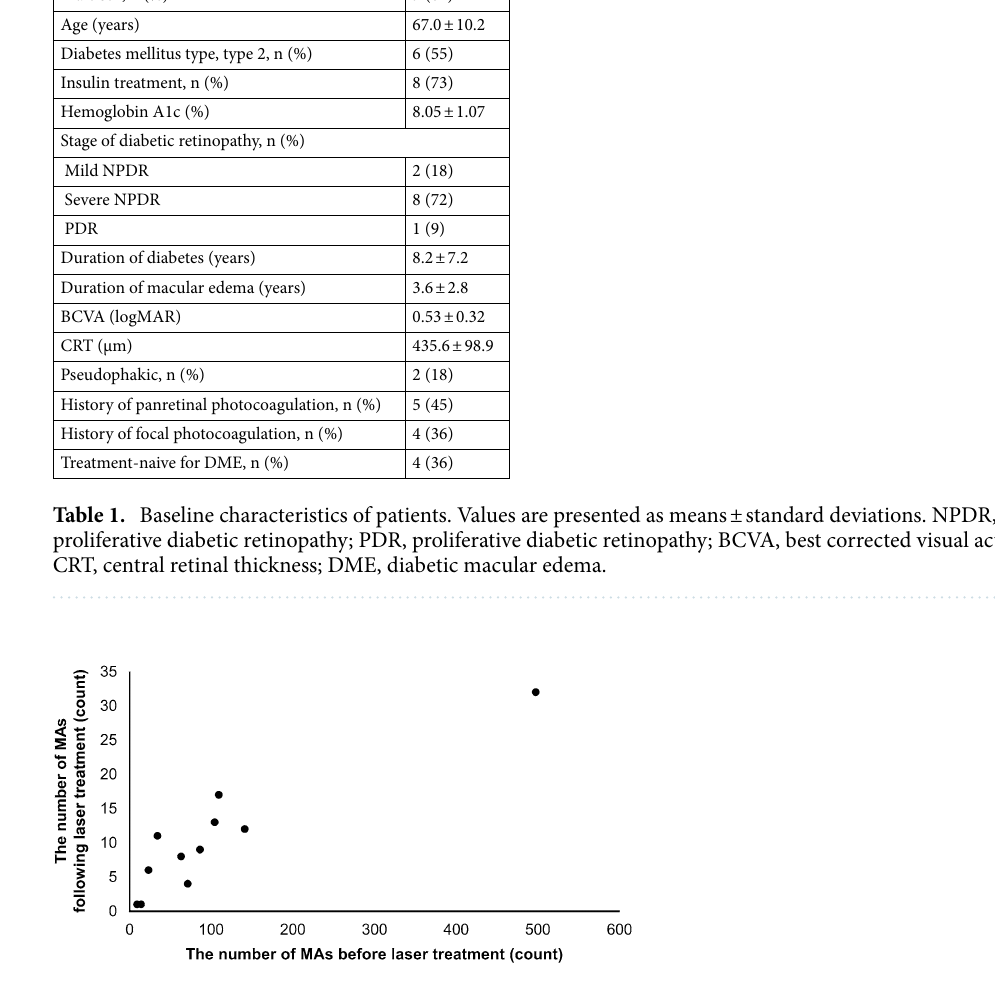
Figure 1. Microaneurysm counts following laser photocoagulation in all cases. MA,